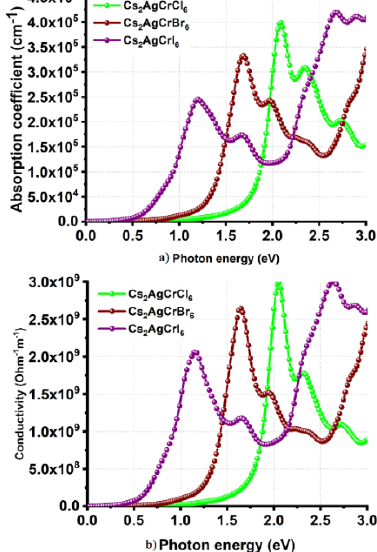
Figure 8. Behavior of the ( a ) absorption coefficient and ( b ) photoconductivity against photon energy for Cs 2 AgCrX 6 (X = Cl, Br, I).